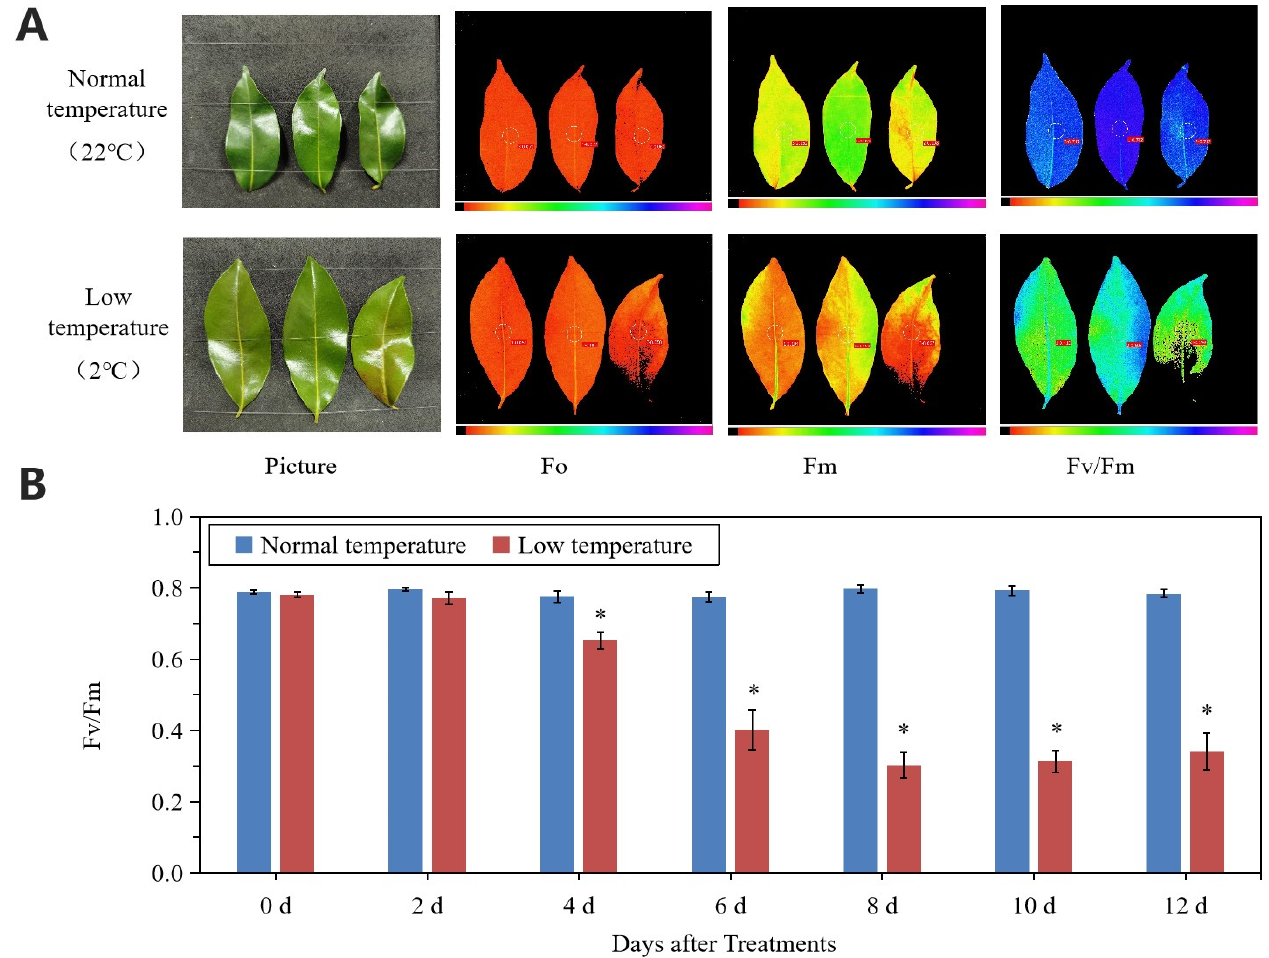
Figure 2. Changes in leaf chlorophyll fluorescence parameters under normal- and low-temperature conditions. ( A ) Phenotype and chlorophyll fluorescence imaging for parameters Fo, Fm, and Fv/Fm for leaves of ‘Huaizhi’ at normal temperature as control and low temperature as treatment at the time point of day 12. ( B ) Fv/Fm values of litchi leaves under low-temperature and normal-temperature conditions. Asterisks (*) indicate significant difference between treatment and control at the same time point ( p ≤ 0.05, n = 3, Student’s t ‐ test).